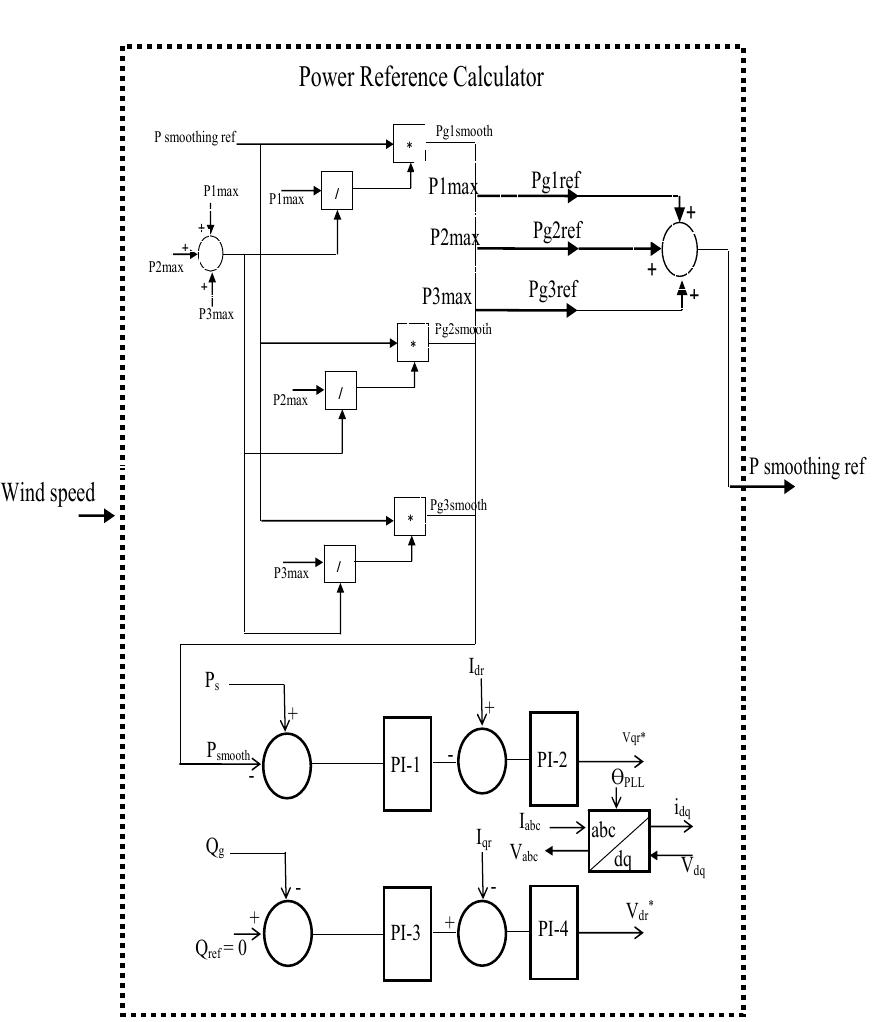
Figure 4. DFIG flywheel reference power calculator (* means reference signal).